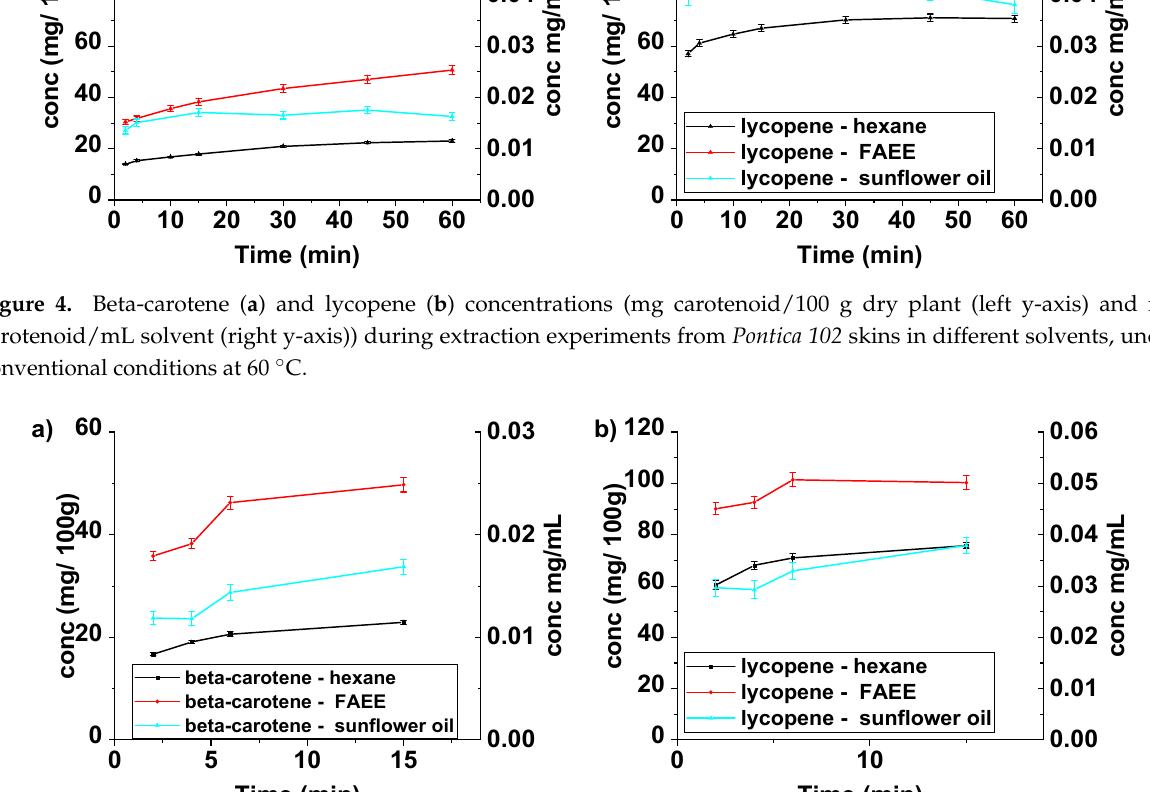
Figure 5. Beta-carotene ( a ) and lycopene ( b ) concentration (mg carotenoid/100 g dry plant (left y-axis) and mg carotenoid/mL solvent (right y-axis)) during extraction experiments from Pontica 102 skins in different solvents, at 60 °C, under US irradiation using Vibracell VCX 750 .